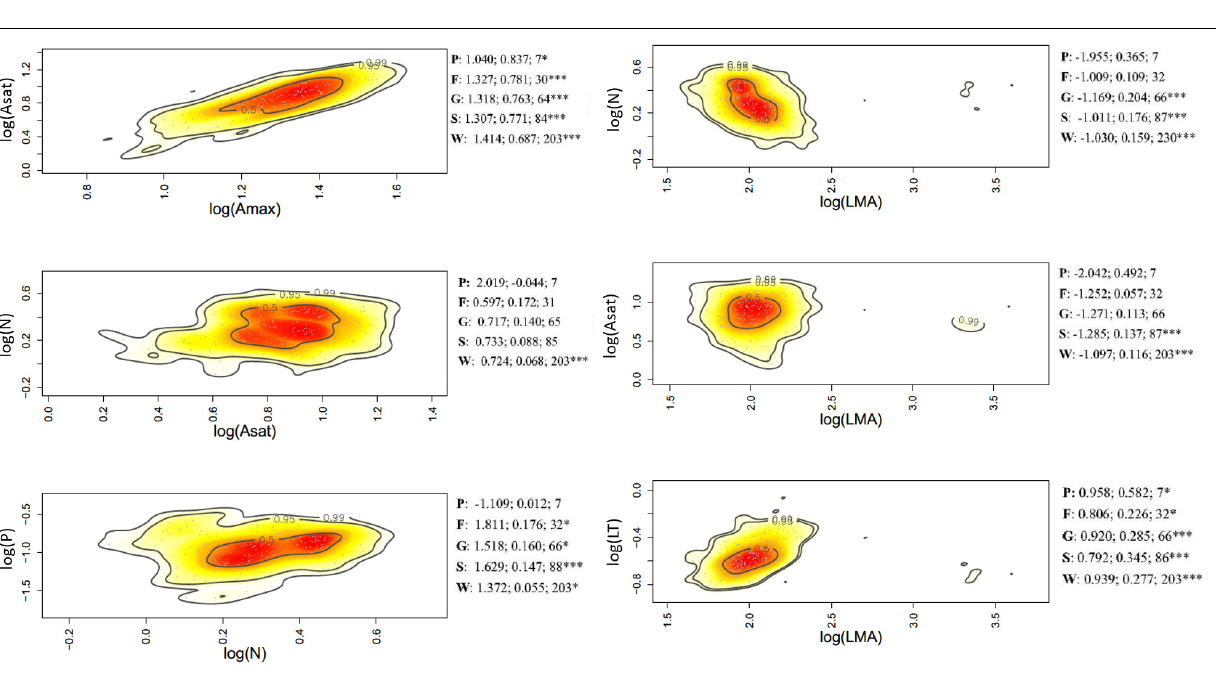
FIGURE 4 | Bivariate trait relationships at the rainfall gradient expressed through kernel density plots for selected trait bivariate relationships, and results of SMA regressions (slope, r2, degrees of freedom) for trait values community weighted at the tree level (W), species (S); genus (G); family (F), and plot (P). Stars *** represent significant after Holm correction. Full results of SMA regression analyses for the whole suite of traits is presented in Supplementary Table S5